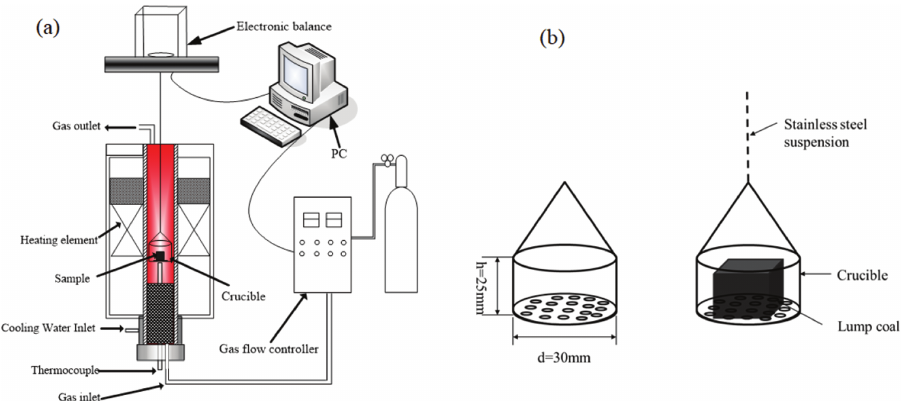
Figure 2: Schematic diagram of the self-designed experimental equipment (a) and alumina crucible (b).